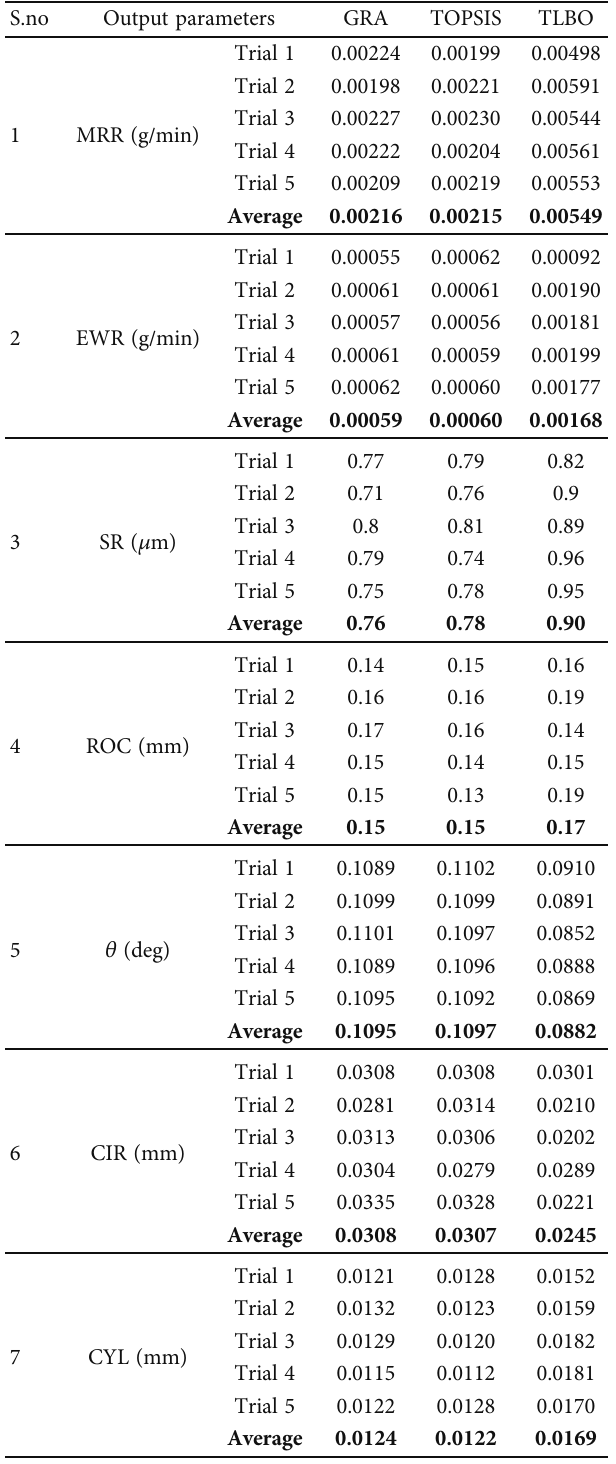
Table 14: Comparison of veri fi cation test for various optimization